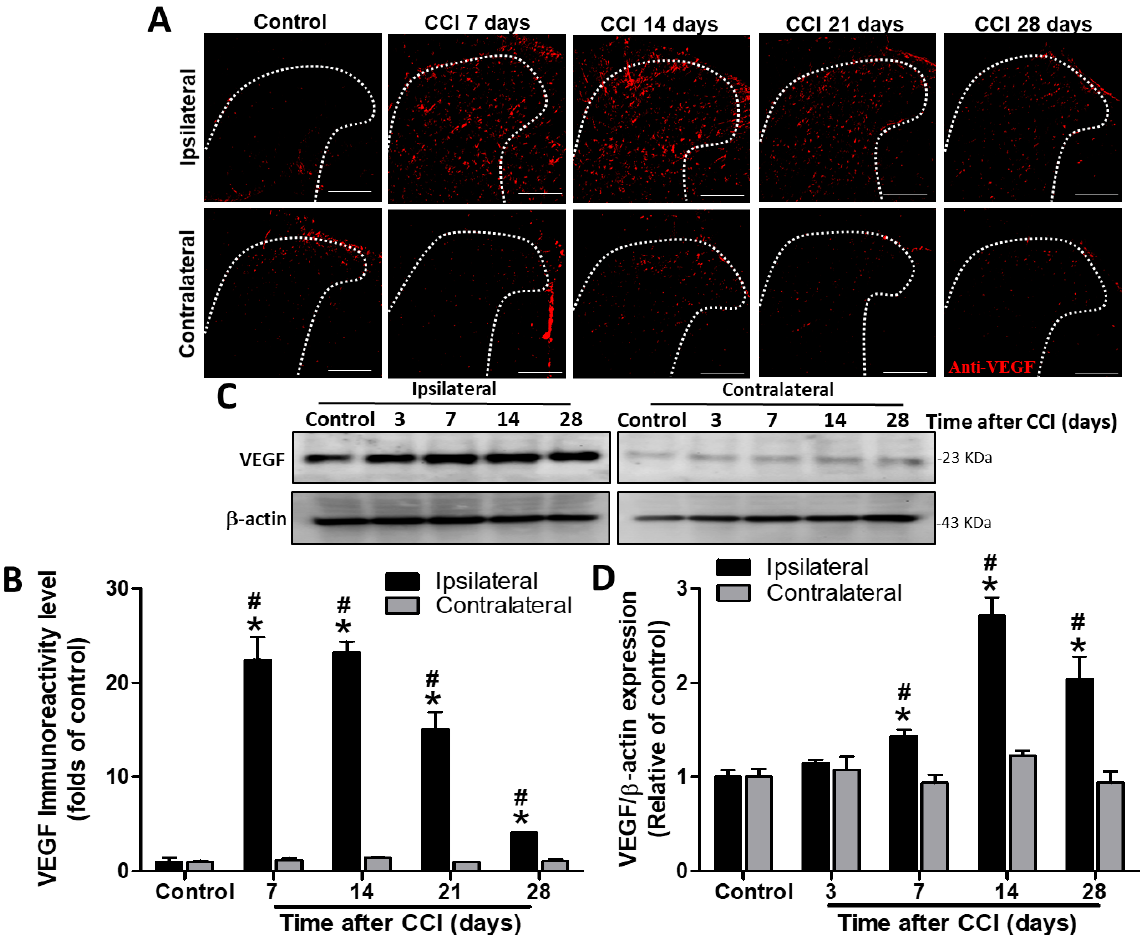
Figure 1. Immunohistochemistry and Western blot analyses of vascular endothelial growth factor (VEGF) expression in the rat lumbar spinal cord dorsal horn (SCDH) during the 28 days after induction of neuropathic pain by chronic constriction injury (CCI). ( A ) Representative VEGF immunofluorescence (red) in the ipsilateral SCDH of controls and CCI rats at post − operative day (POD) 7, 14, 21, and 28 (20 − µm sections; magnification: 100×; scale bars: 300 µm). ( B ) Quantification of immunofluorescence reactivity in the contralateral and ipsilateral SCDHs (4 sections per rat, 3 rats per group and each time point). ( C ) Representative VEGF and β− actin Western blots in the ipsilateral spinal cord of control rats and CCI rats at POD 3, 7, 14, and 28 ( n = 3 at each group and each time point). ( D ) Quantification of the Western blot results. The loading control was β− actin, the quantification was performed on four rats per group, and values are expressed as means ± standard error of means (SEMs). * p < 0.05 relative to the same side of controls; # p < 0.05 relative to the contralateral side of the same group at the same time point, one-way analysis of variance (ANOVA) with post hoc Tukey test.